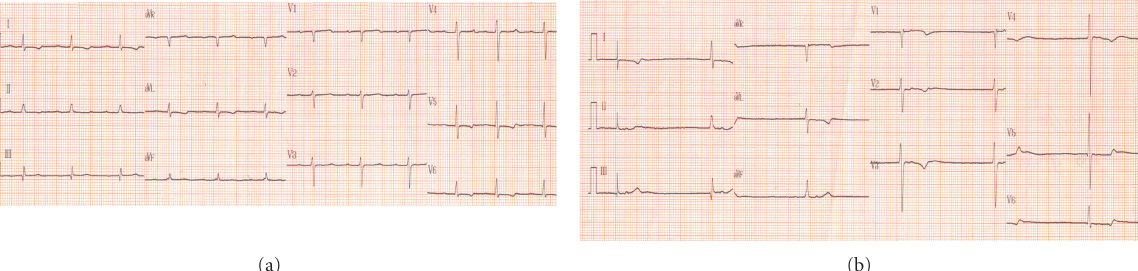
Figure 1: (a) Electrocardiography on admission showed first-degree atrioventricular block. (b) One day later when hyperkalemia was found, electrocardiography showed junctional bradycardia.